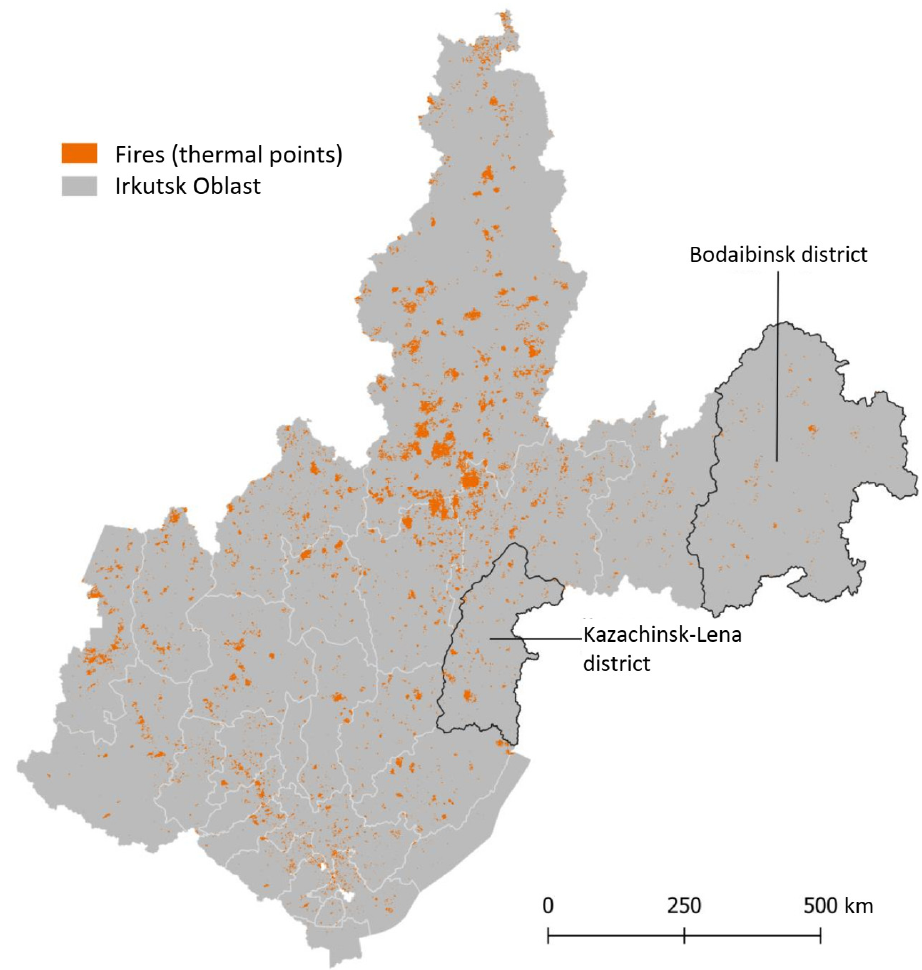
Figure 3. A map of Irkutsk Oblast displaying thermal points for